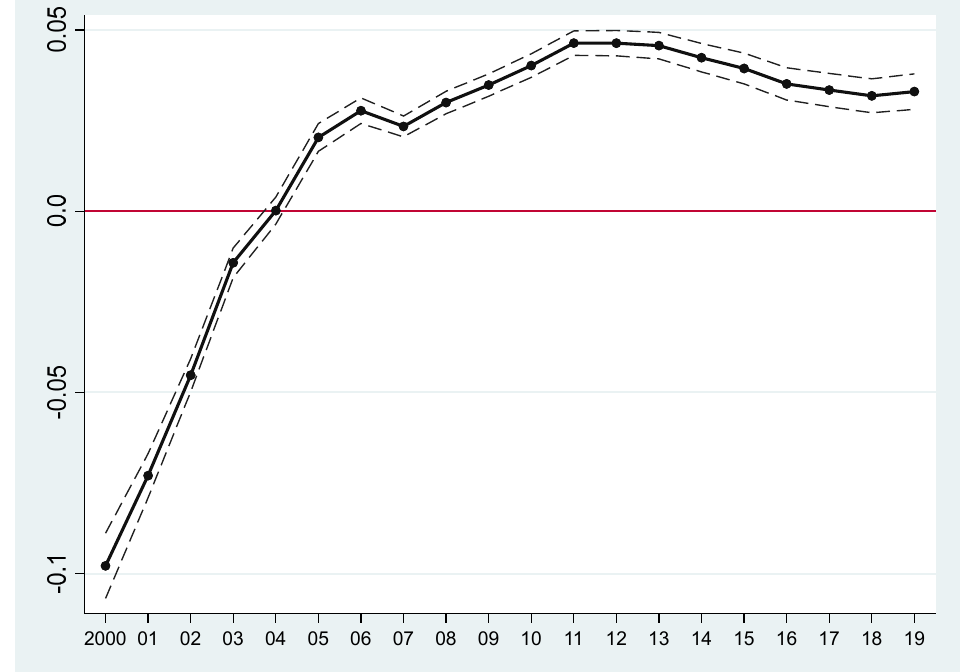
Figure 2. Time-varying effects of urban construction land use on carbon emissions. Note: the black solid line represents the estimated time-varying coefficients of lnland by estimating the fixed-effects model with varying coefficients, and the area enclosed by the two black dashed lines is the 95% confidence interval for the coefficient of lnland.